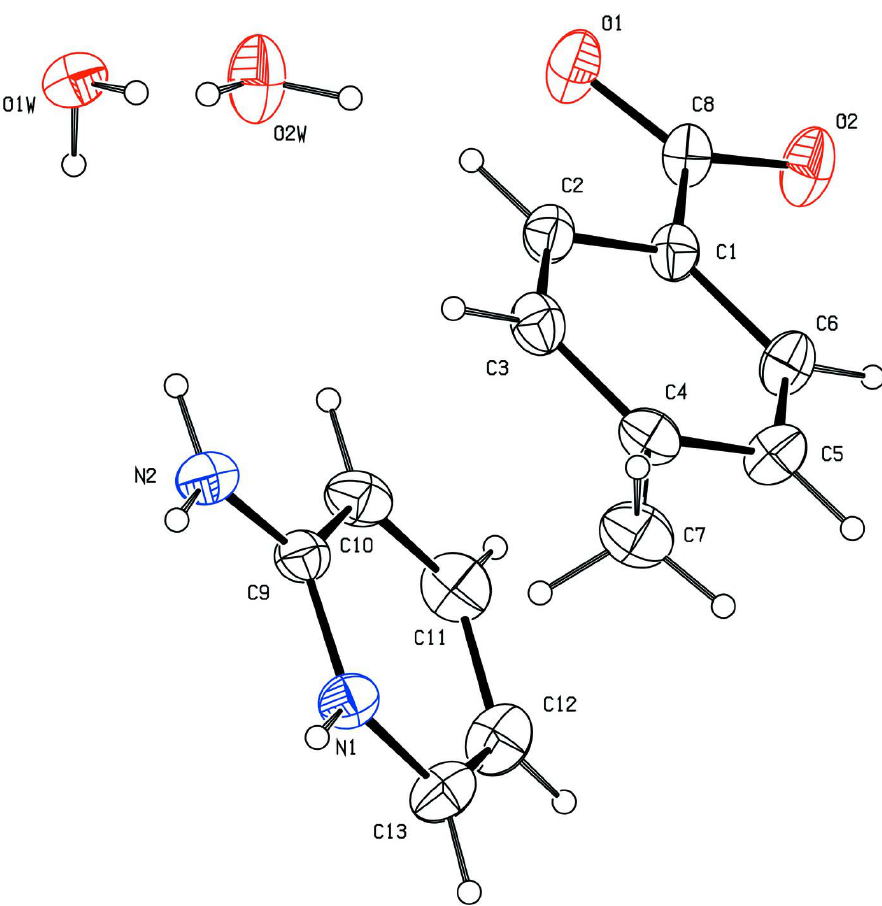
Figure 1 The molecular structure of (I), with displacement ellipsoids for the non-hydrogen atoms drawn at the 50% probability